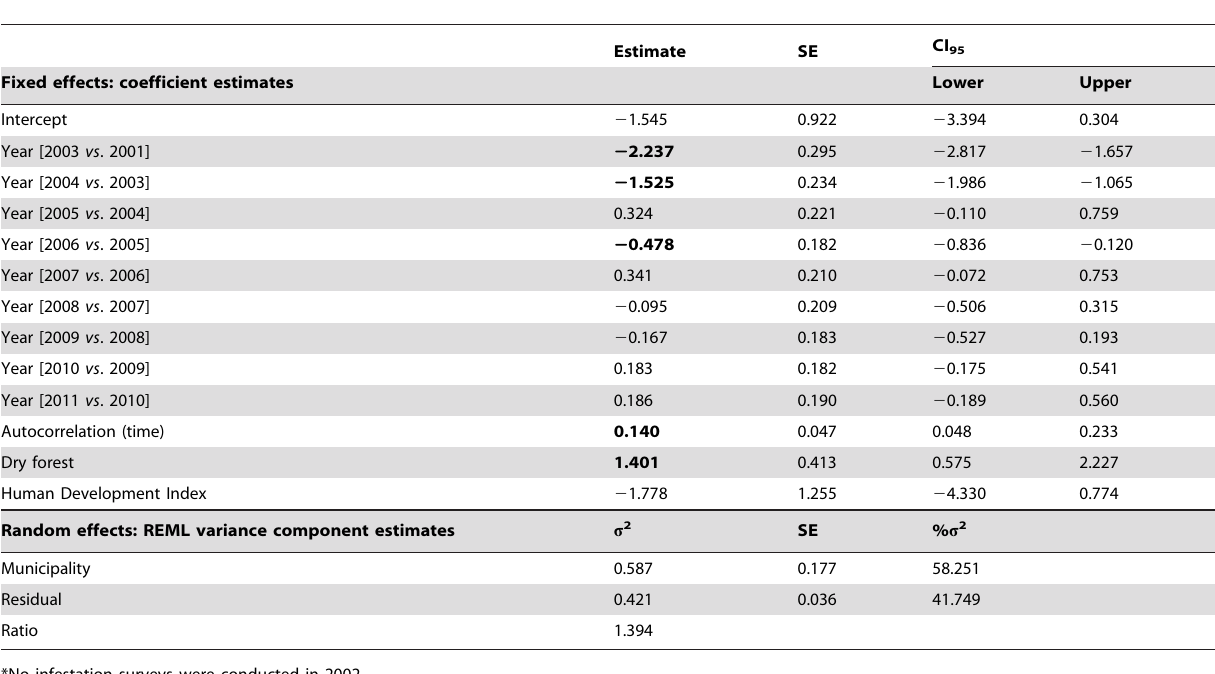
Table 4. Dwelling infestation by triatomine bugs in 39 municipalities, Cochabamba, Bolivia, 2000–2011*: linear mixed model results, with year specified as an ordinal, fixed effect (number of parameters k =15; BIC= 812.32;